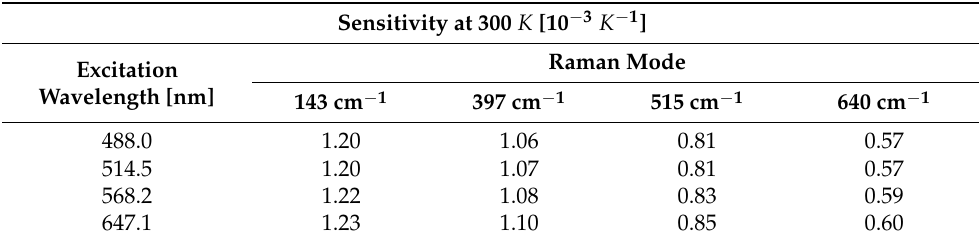
Table 6. Sensitivity at 300 K of the anti-Stokes/Stokes ratio to temperature, calculated for the 143, 397, 515 and 640 cm − 1 modes of anatase.